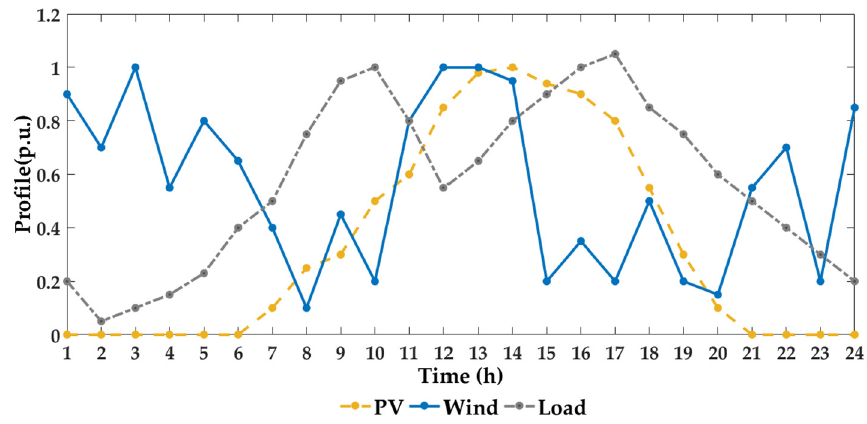
Figure 6. Daily operation curve of DGs and loads.